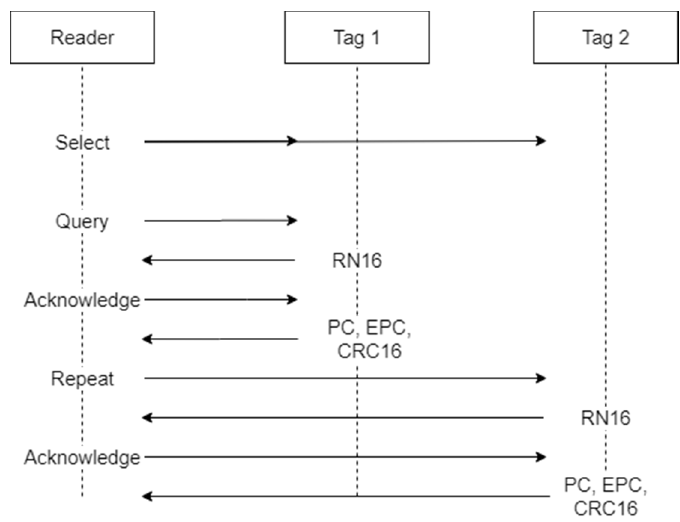
Figure 2. Basic steps of the EPC-Global Class-1 Gen-2 communication protocol. In the figure, an example of the interaction between a reader and two tags is depicted.